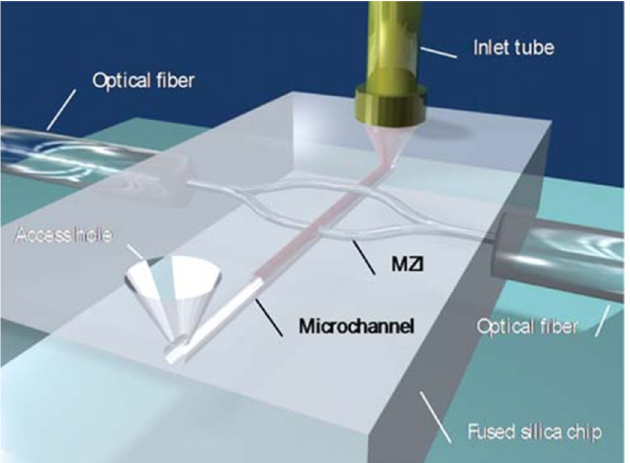
Figure 8. Schematic of the femtosecond laser-fabricated microfluidic channel and integrated Mach- Zender interferometer. The sensing arm crosses the channel orthogonally, while the reference one passes over it. Adapted from Reference [142].